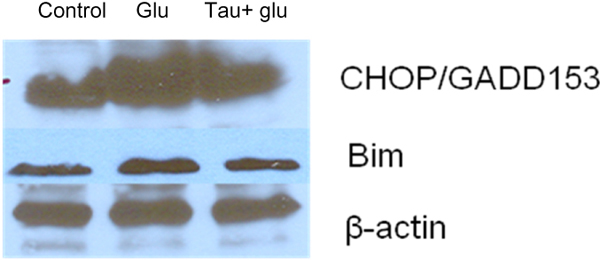
Effect of taurine on glutamate-induced elevated expression of CHOP and Bim by Western blot analysis. Primary cortical neurons were treated the same as described in Figure 5 except that the expression of CHOP and Bim was analyzed by Western blot assay.